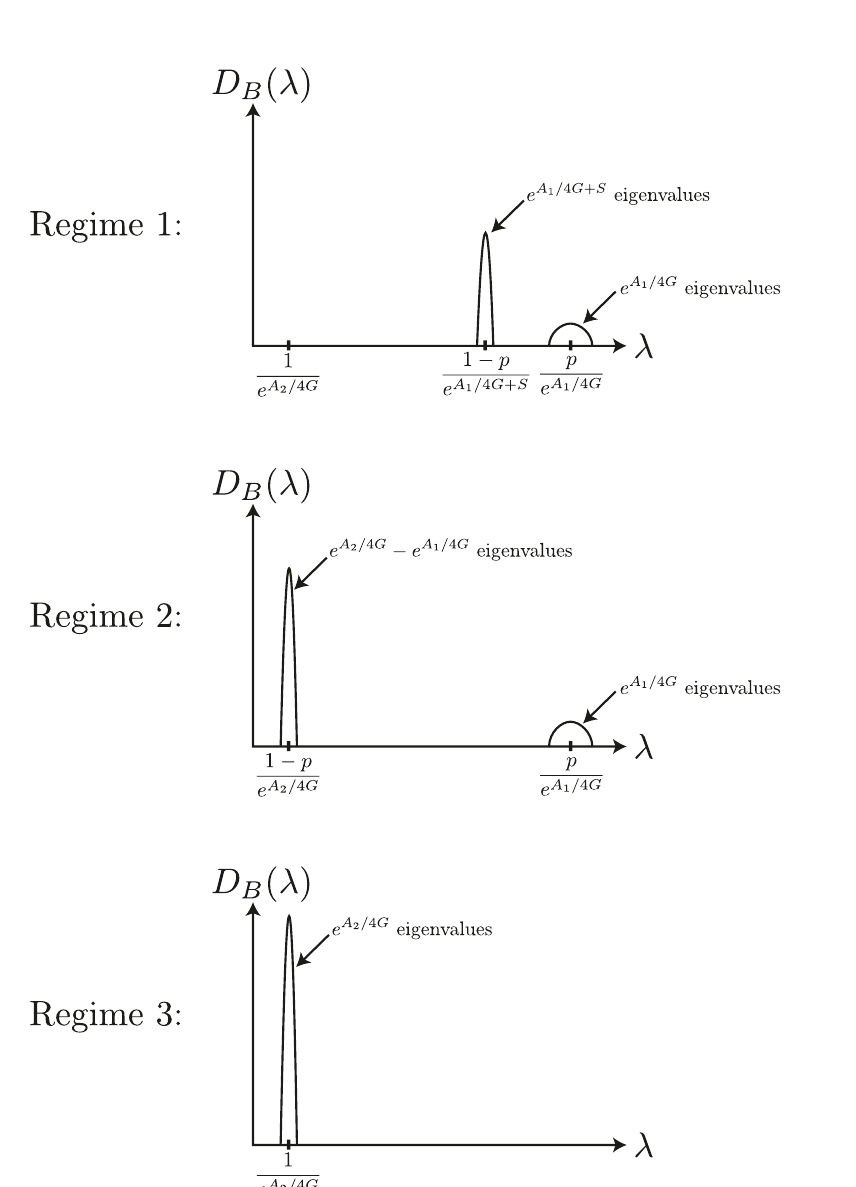
Figure 5 . Eigenvalue density for the three Regimes in section 4.3. In Regime 1, there are two peaks of eigenvalues, each associated to one of the two states in the mixture, and each much greater than the critical value 1 /e A 2 / 4 G . Hence the naïve QES prescription is correct. In Regime 2, one of the peaks has shifted to the critical value, while the other remained where it was, leading to large corrections in the naïve QES prescription. In Regime 3, both peaks have moved to the critical value, and the naïve prescription is valid again. Note the agreement with numerical results for the analogous random tensor network in appendix